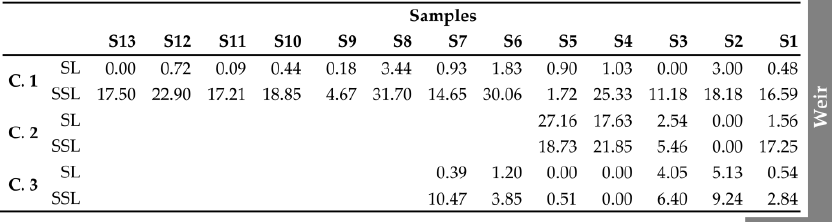
Figure 3. Results of the median diameter d 50 (mm) of the surface layer (SL) and subsurface layer (SSL).